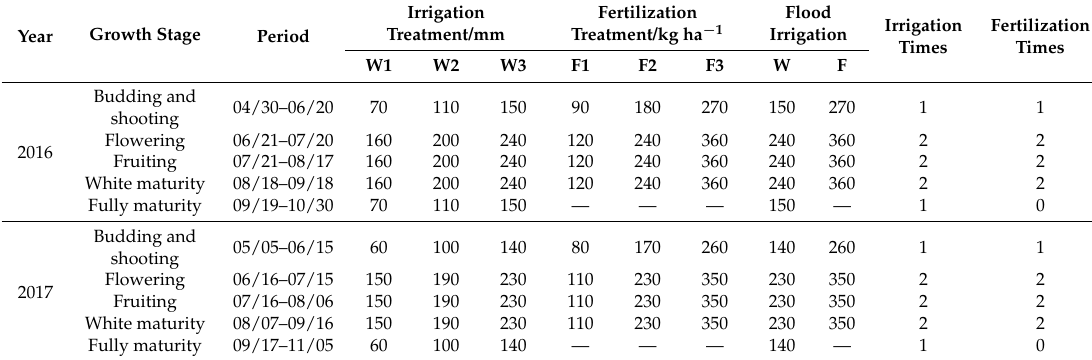
Table 2. Irrigation and fertilizer managements in